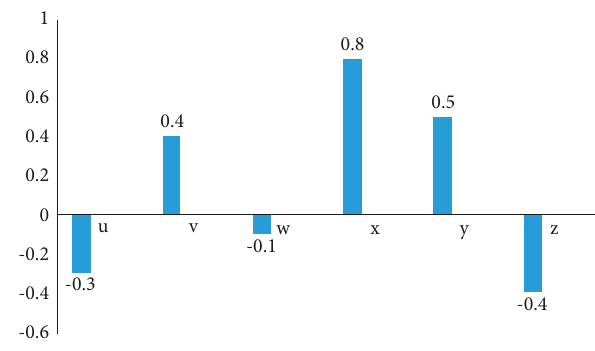
Figure 2: Bipolar fuzzy